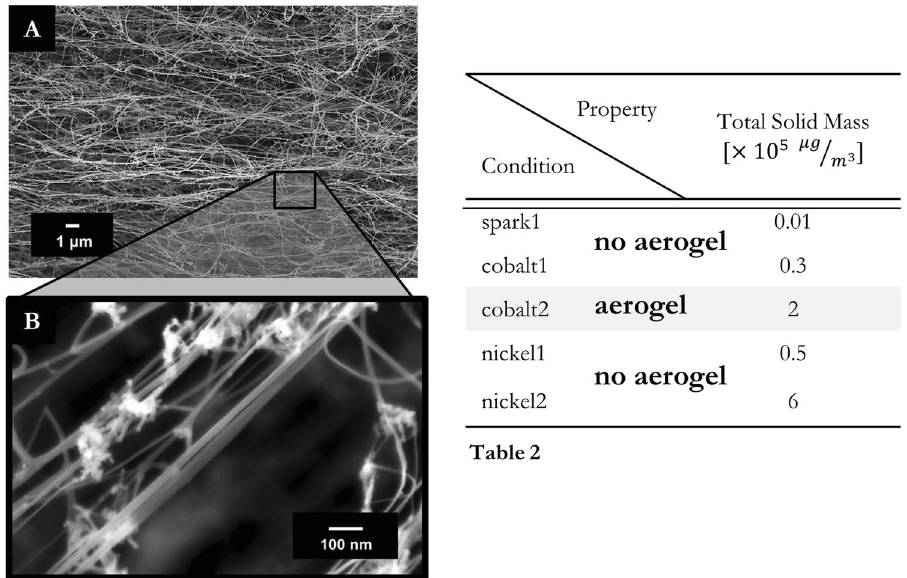
Figure 5. Effect of critical mass concentration on aerogel formation for Fe, Ni and Co sources. ( A and B ) SEM analysis of CNT web formed from a cobaltocene precursor showing the same features as that from a ferrocene precursor. Table 2 shows the conditions for spark generated catalyst nanoparticles (spark1), catalyst nanoparticles from cobaltocene (cobalt1 and cobalt2) and catalyst nanoparticles from nickelocene (nickel1 and nickel2) with the addition of thiophene leading to aerogel formation for condition cobalt2 and no aerogel formation for the others due to the total solid mass being below the critical mass concentration for conditions spark1, cobalt1 and nickel1. cobalt2 is at the same time the lowest mass concentration of cobalt capable of aerogel formation and therefore gives a critical mass concentration for cobalt of ( > 2 × 10 2 mg/m 3 ).